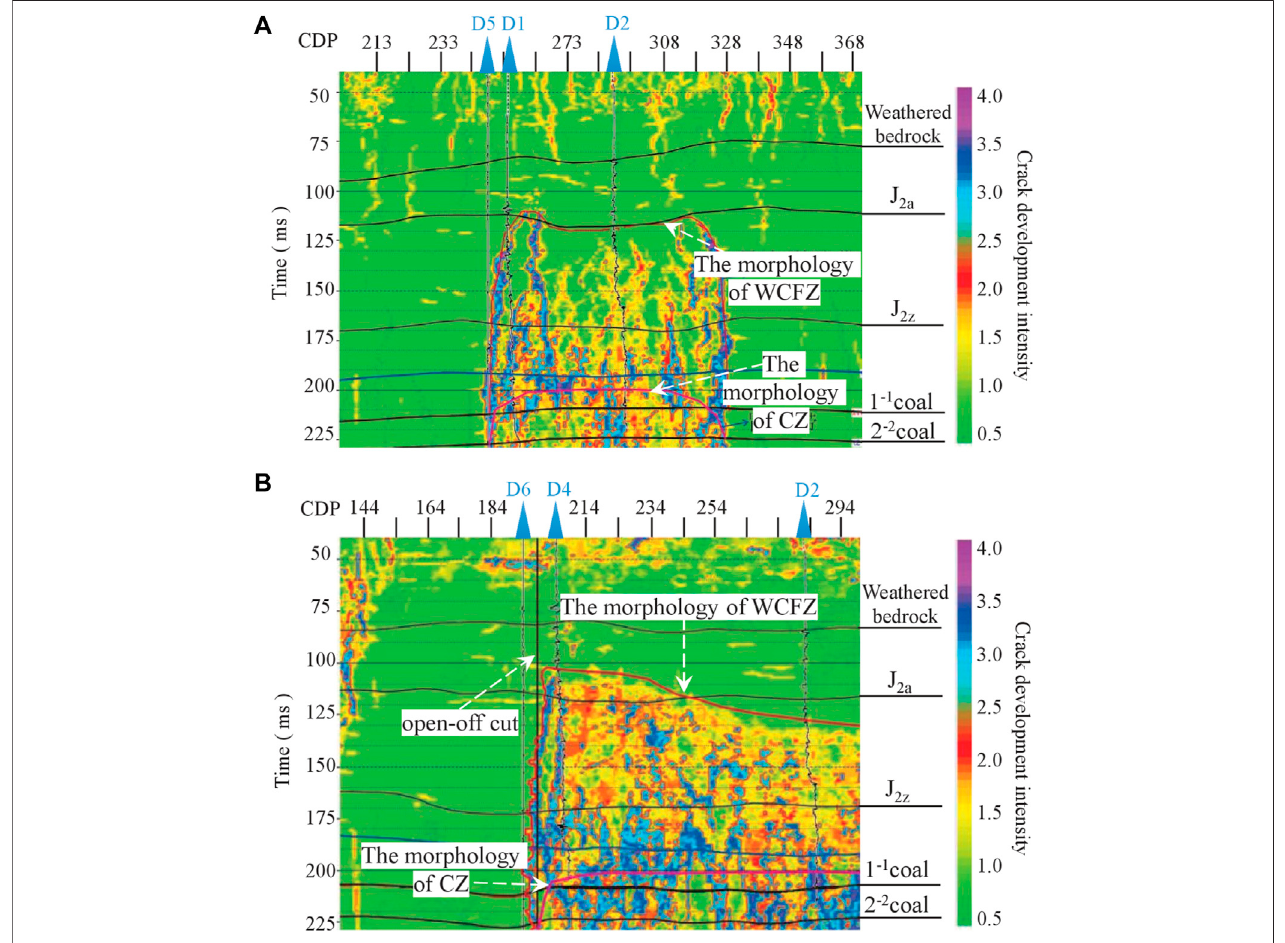
FIGURE9| Fractureindicatorinversionpro fi le: (A) Inversionpro fi leofworkingfaceinclineand fi ssureindicationand (B) inversionpro fi leofworkingfacestrikecrack indication.